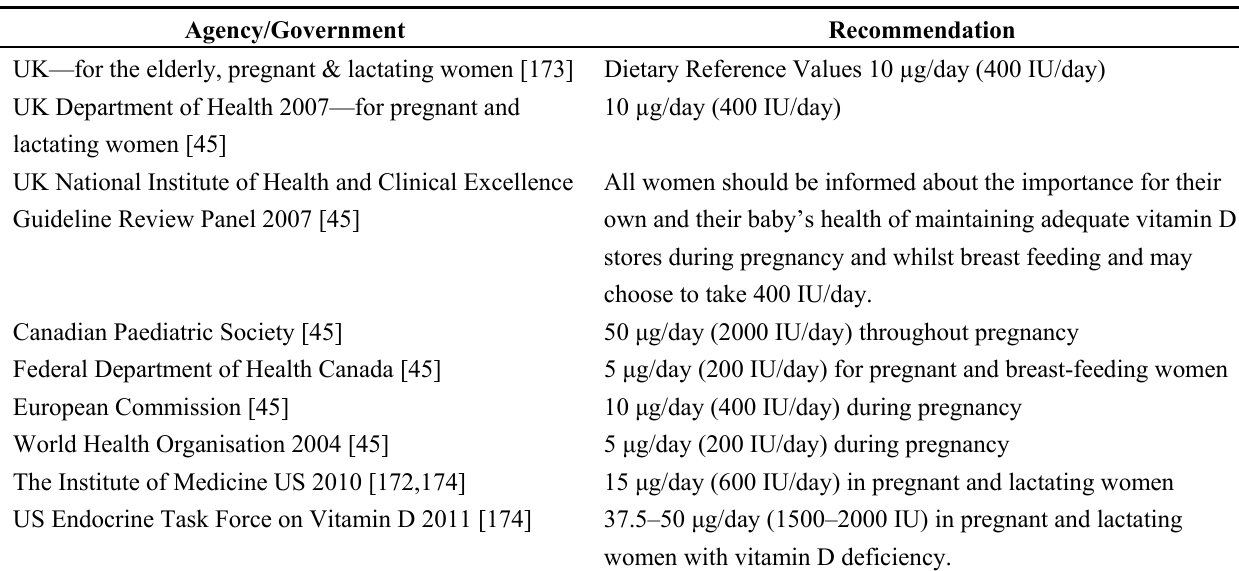
Table 1. Vitamin D intake recommendations during pregnancy and